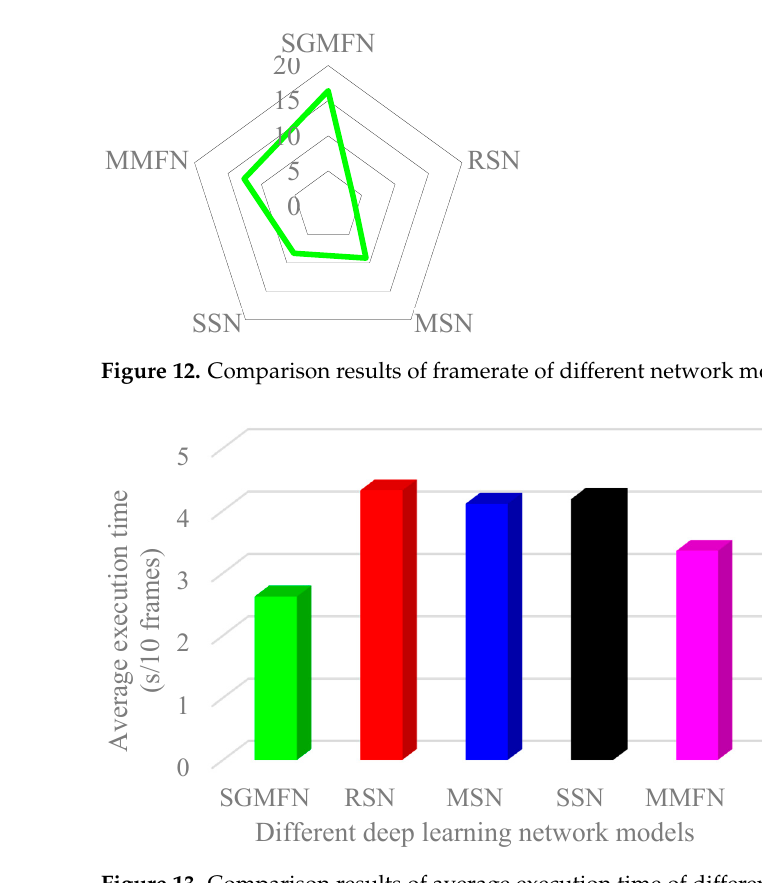
Figure 13. Comparison results of average execution time of different network models.